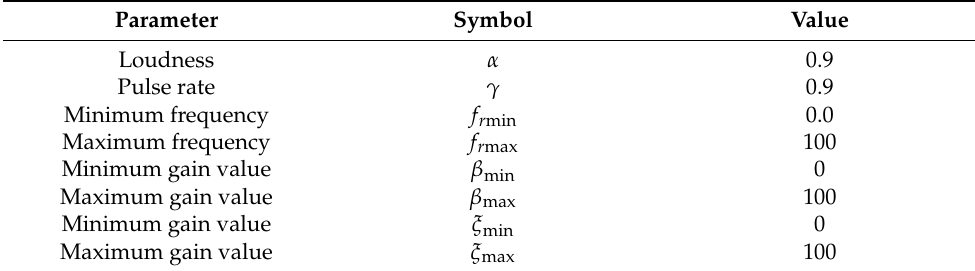
Table 2. Bat algorithm